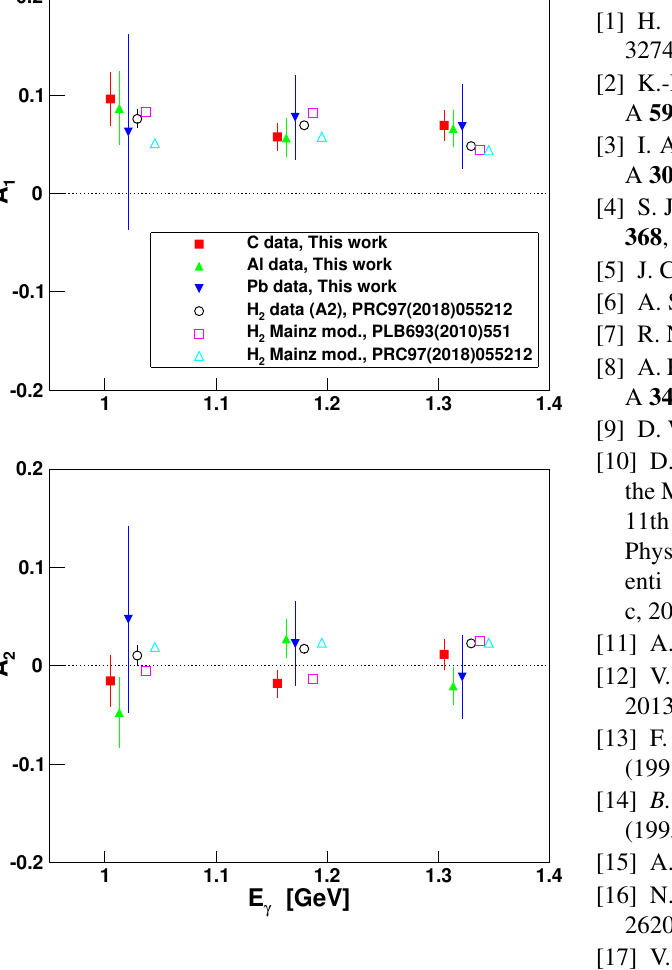
Figure 8. Coe ffi cients A 1 and A 2 obtained from fitting I (cid:12) ( Φ ) distributions with a function from Eq. (2). Shown are the coe ffi - cients obtained for the nuclear targets, free proton data [37], and results from the previous [25] and the latest Mainz model [37]. Figure taken from Ref.